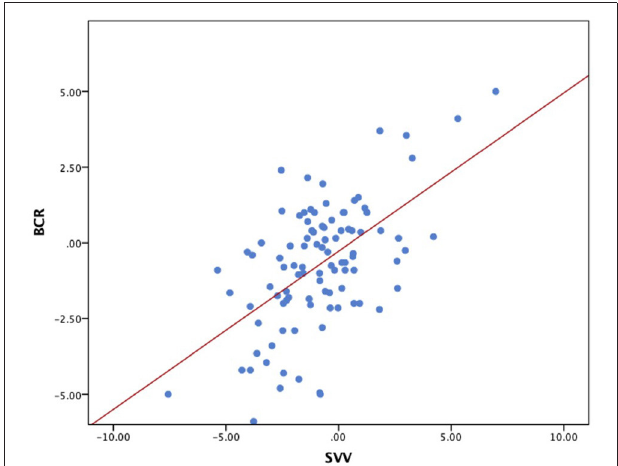
FIGURE 6 | Scatterplot of BCR (x-axis) vs. oVEMP asymmetry ratio (y-axis). BCR, binocular cyclorotation; oVEMP, ocular vestibular evoked myogenic potential.